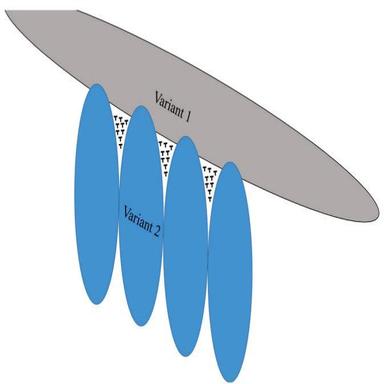
Formation of zig-zag shaped dislocation arrangements due to interaction of different martensite variants.